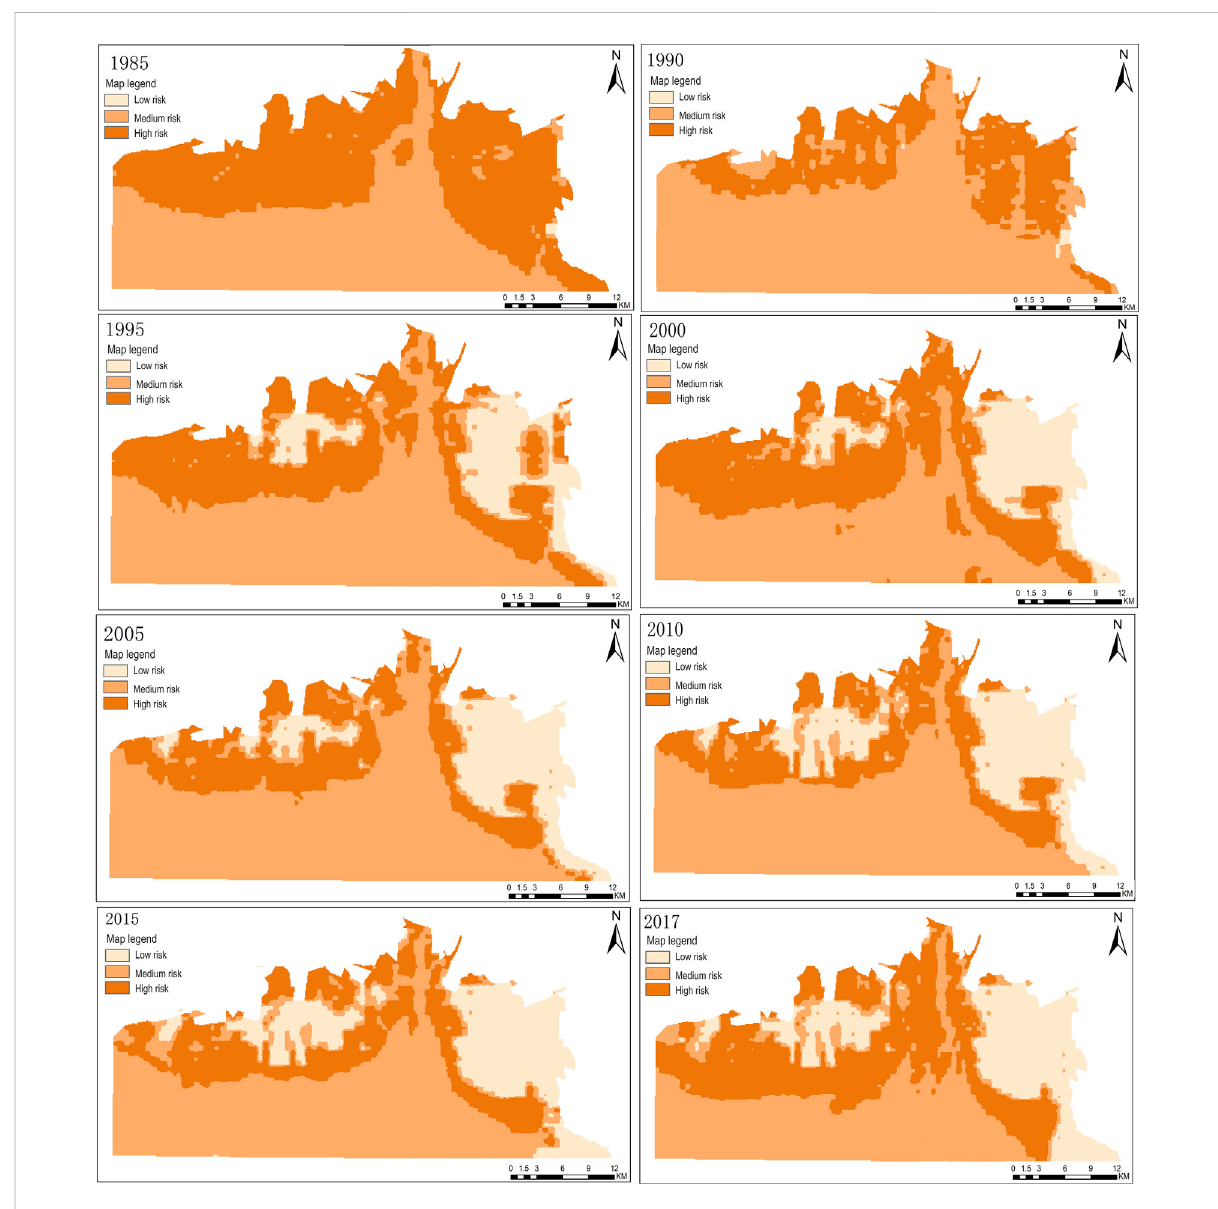
FIGURE 4 Landscape Ecologic risk index Spatial distribution in the